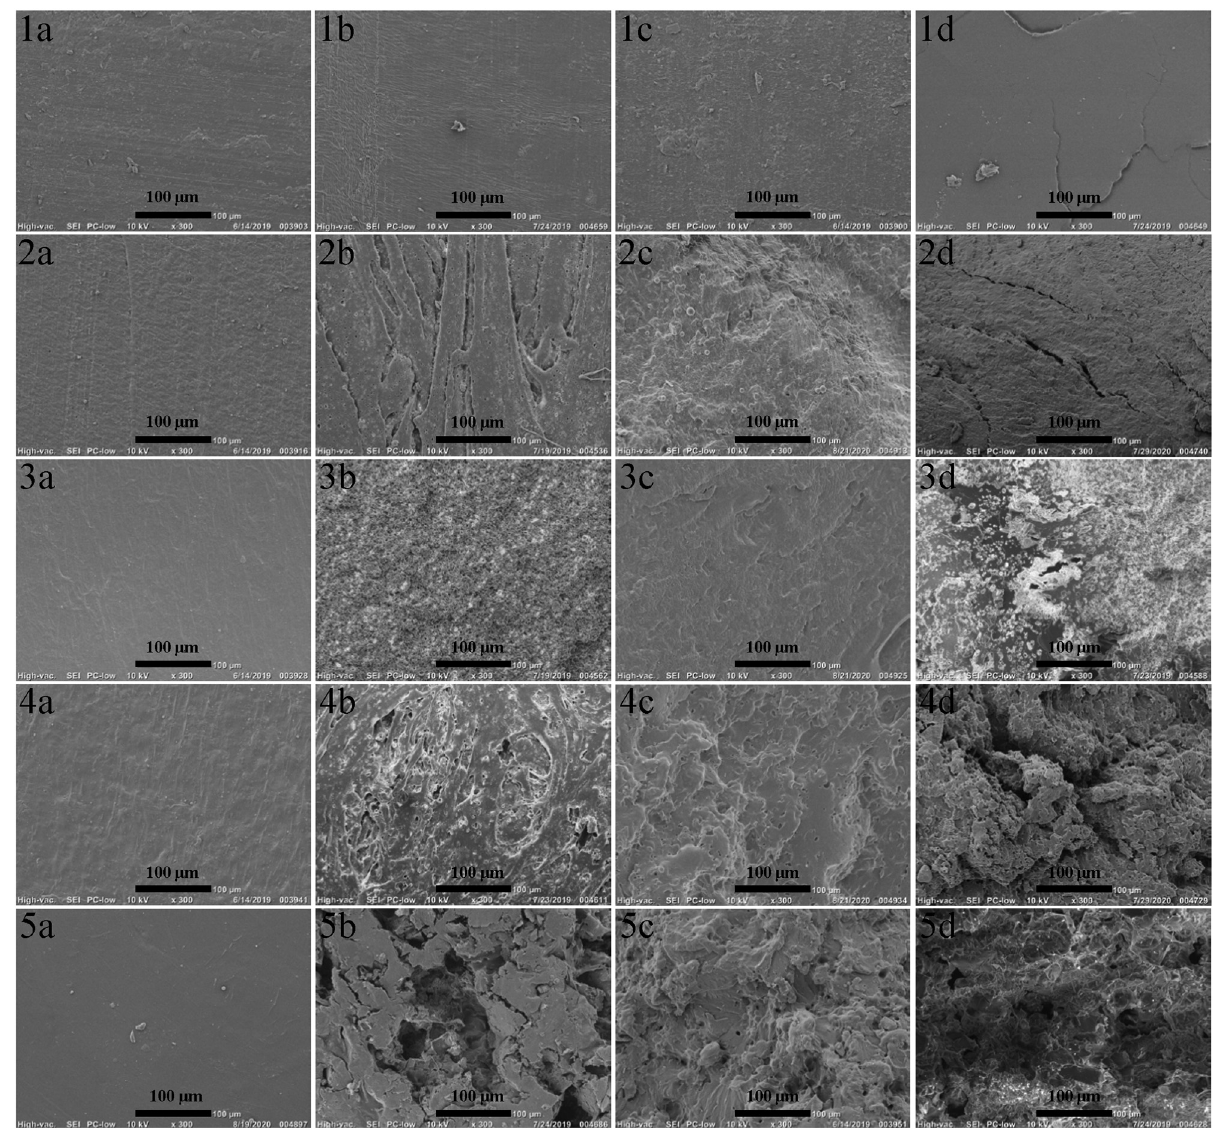
Figure 4: SEM images of PLA and PVA/PLA specimens after immersion in natural seawater for 180 days: ( 1 ) PLA, ( 2 ) PVA0588/PLA = 30/70, ( 3 ) PVA0588/PLA = 50/50, ( 4 ) PVA1788/PLA = 30/70, ( 5 ) PVA1788/PLA = 50/50, ( 1a – 5a ) surfaces of the specimens before degradation, ( 1b – 5b ) surfaces of the specimens after degradation, ( 1c – 5c ) cross - sections of the specimens before degradation, ( 1d – 2d, 4d – 5d ) cross